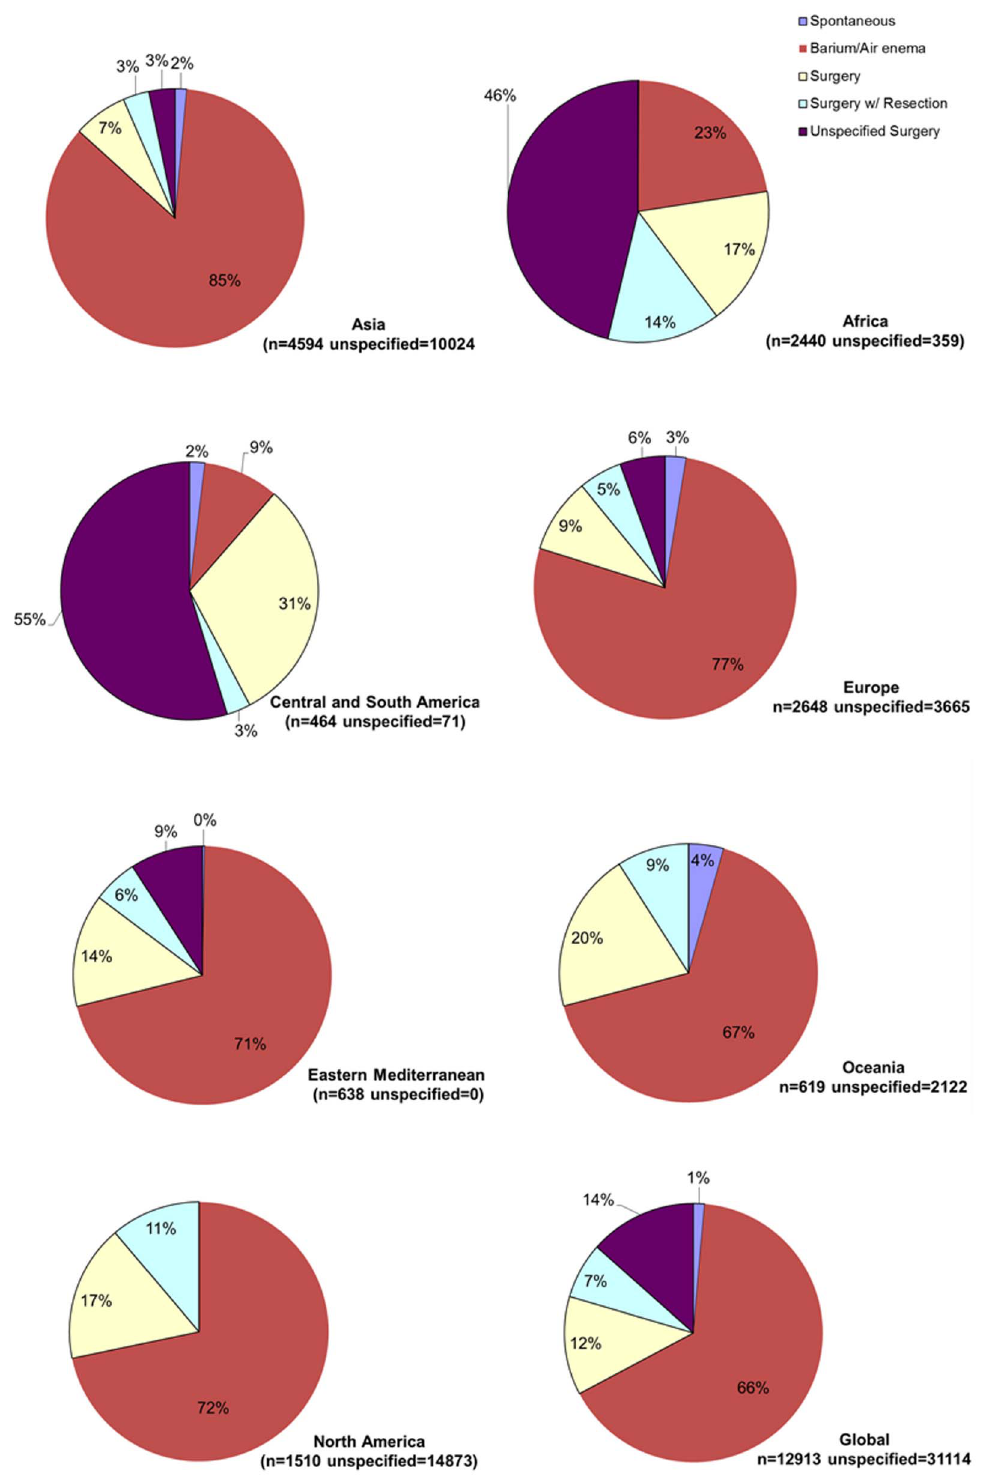
Figure 7. Treatment of intussusception by WHO region. Studies where treatment was unspecified were not included.